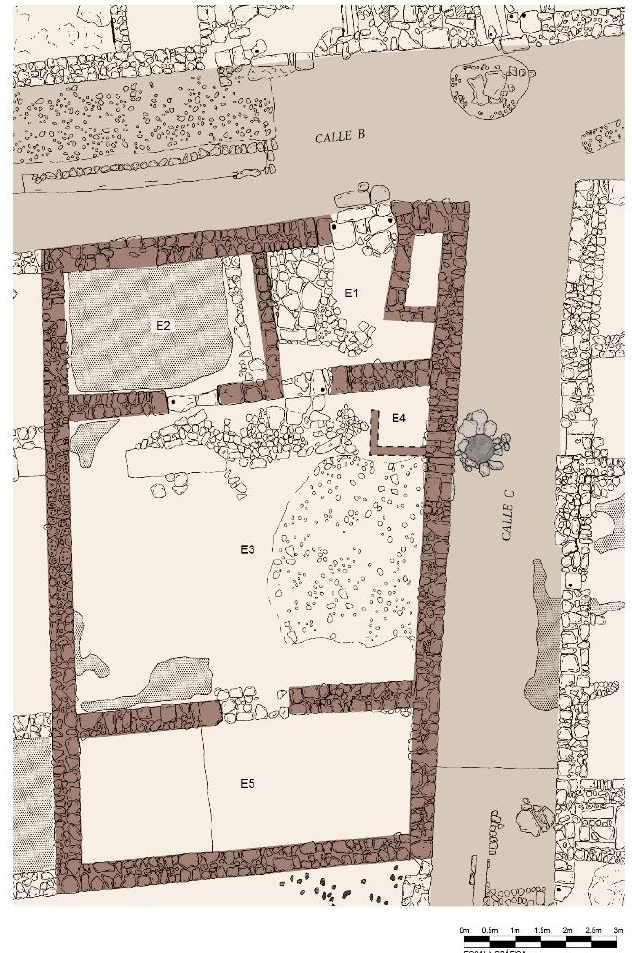
Figure 18. Variant 2. House 119. Plan and room distribution.